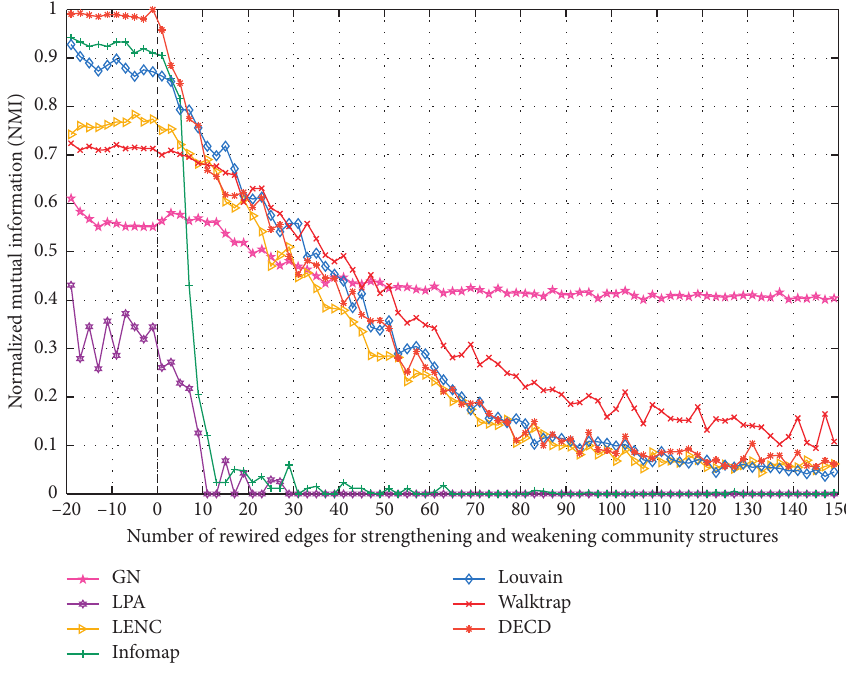
Figure 8: The average optimal value of NMI obtained by typical community detection algorithms on a set of benchmarks with gradually modified community intensity, which are generated based on the anatomical connection network of macaque cortex. Each data point is obtained based on averaging 10 independent runs of each algorithm on each benchmark. The negative and positive values of the abscissa represent the number of rewired edges when the community structure is strengthened and weakened,